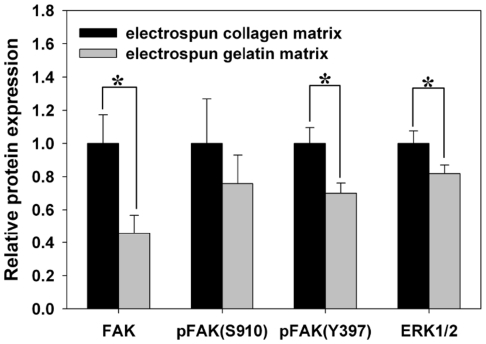
Effects of matrix on FAK and phospho-FAK and ERK1/2 activation in MG63 osteoblasts-like cell.Densitometric quantitation of the protein bands was performed after normalizing to nucleophosmin B23 levels. (Figure S1 shown the images of full western blots). Data are shown as the fold change of the corresponding 2 h of incubation on the EC. The total FAK levels expressed by MG63 osteoblast-like cells were significant higher in cells grown on EC than in those grown on EG. Moreover, the level of FAK phosphorylation at tyrosine 397 was lower in cells grown on EG than in those grown on EC. Data are presented as mean ± SD, n = 3. Statistical analysis was compared between EC and EG. (*) denotes a significant difference (p<0.05).